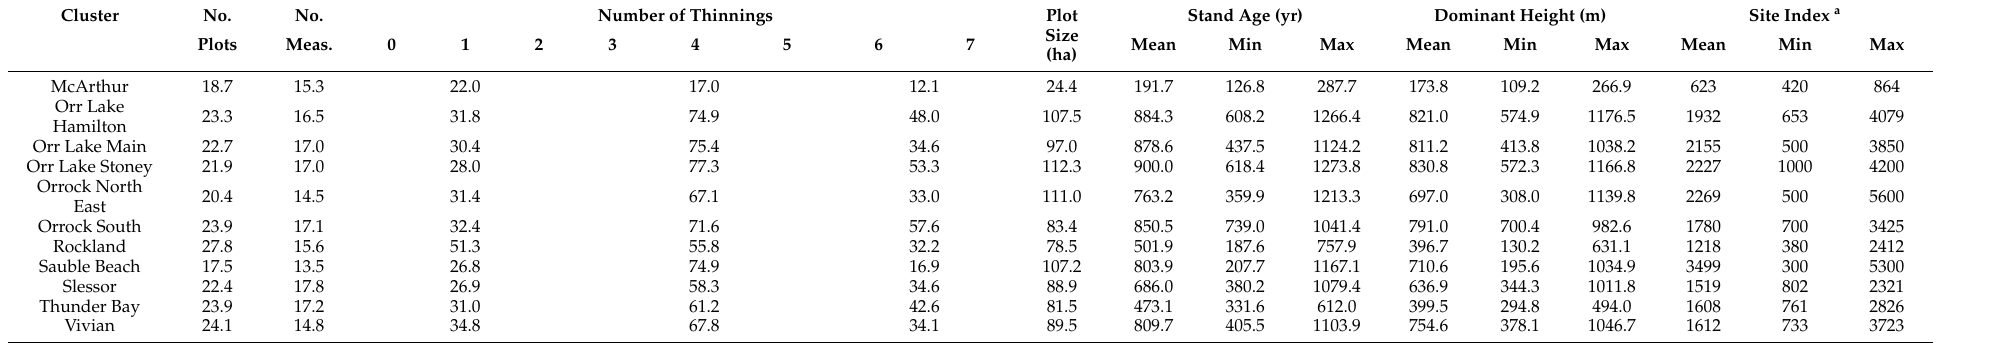
Denotations: (1) Number of periodic remeasurements per plot within a given cluster (No. Meas.); (2) Min and Max refer to minimum and maximum values respectively; (3) D q , G , V t , V m and N refer quadratic mean diameter, basal area, total volume, merchantable volume and stand density, respectively (see Section 2.1 for computational specifics). a Mean dominant height at a breast-height age of 50 yr